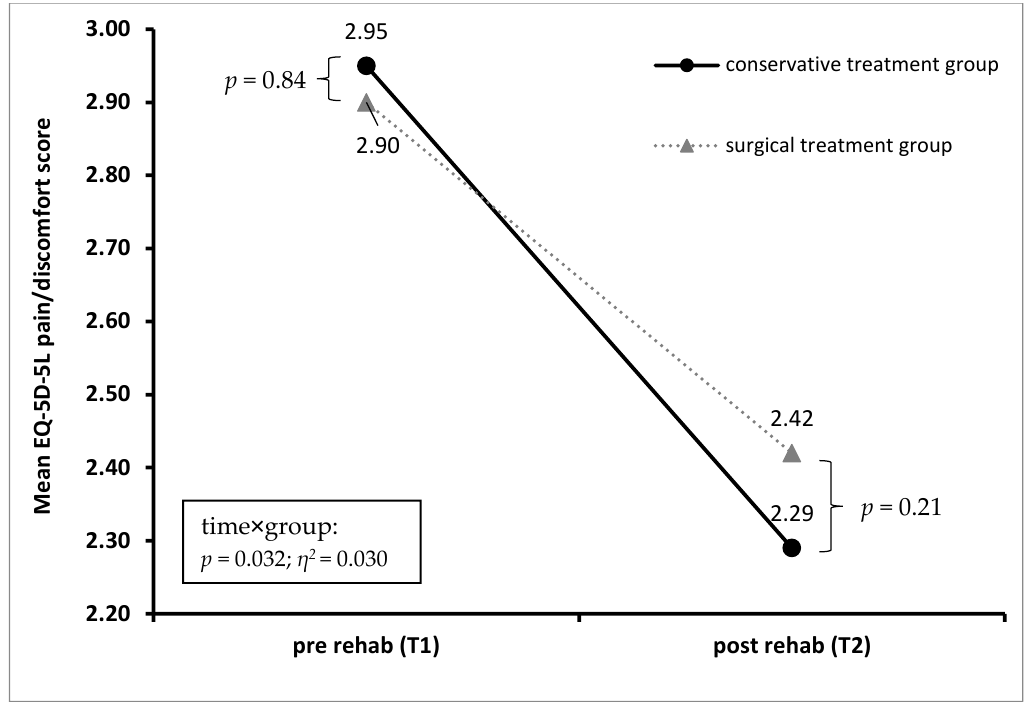
Figure 4. Mean EQ-5D-5L pain/discomfort score before ( T 1) and after ( T 2) rehabilitation treatment for patients in the conservative and surgical treatment groups. When patients were grouped into categories of good, average, and bad performers based on the T2D scores of the NDI, a statistically significant difference was detected be- tween the two treatment groups (χ 2 = 7.67, p = 0.022), with patients in the op-group show- ing a larger proportion of bad performers (50.9% vs. 29.0%) and fewer average (21.8% vs.